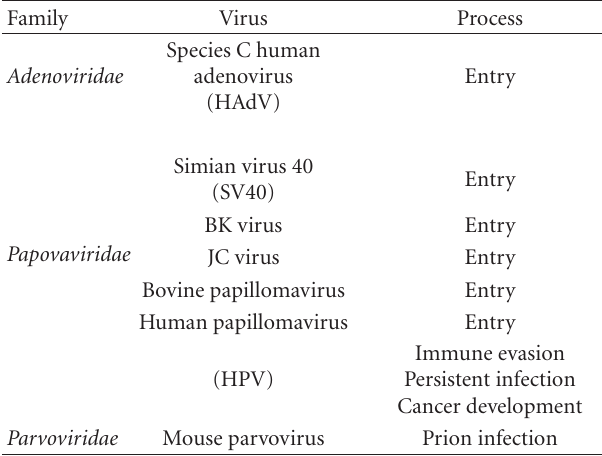
Table 3: Function of membrane rafts in nonenveloped DNA viru- ses.